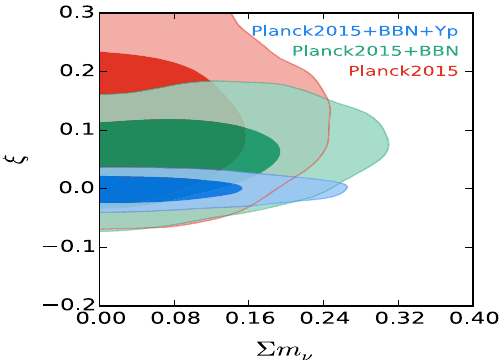
Fig. 5 Marginalized two-dimensional contours in the ξ − (cid:2) m ν plane with 68 and 95% confidence level in the extended (cid:19) CDM model with BBN consistency, derived from the data of Planck 2015 + JLA + BAO ( green ) and Planck 2015 + JLA + BAO + Y p ( blue ). The red contours correspond to Y p = 0 . 24, derived from Planck 2015 + JLA +